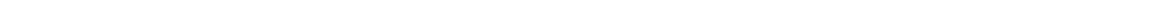
Fig. 1 Widespread intronic polyadenylation in immune cells. a Schematic representation of full-length and IpA isoform of IGHM expressed in mature B cells and plasma cells (PC). b The 3 ʹ -seq (tags per million (TPM)) and RNA-seq (read coverage) tracks showing expression of the IpA and full-length mRNA isoforms of IGHM (ENSG00000211899), encoding the immunoglobulin mu heavy chain, IgM. The full-length isoform is expressed in NB from blood and lymphoid tissue and includes two exons encoding the C-terminal transmembrane domain of membrane-bound IgM. The IpA isoform is expressed in PCs obtained from bone marrow. It lacks the transmembrane domain which leads to expression of soluble IgM. c The 3 ʹ -seq tracks showing IpA isoform expression for two genes across human tissues and immune cell types. d RNA-seq coverage of intronic regions fl anking IpA sites. A GLM-based test is used to validate the IpA isoforms. An isoform is considered validated if there is a signi fi cant difference (FDR-adjusted P < 0.1) in read counts in windows located up- and downstream of the putative IpA site. e The fraction of IpA isoforms validated by read evidence from independent data sets is shown for annotated and unannotated IpA isoforms. IpA isoforms present in RefSeq, UCSC genes, and Ensembl databases are considered to be annotated. f The fraction of expressed genes that generate IpA isoforms is shown for each cell type. g Expression levels (log 2 TPM) for full-length mRNAs and IpA isoforms are shown as boxplots for in PCs, blood NB, and T cells. IpA isoforms are robustly expressed as full-length mRNA expression is 4.53, 5.15, and 5.11, respectively, compared to 3.71, 3.83, and 3.71 for IpA isoforms. h Tissue-speci fi c expression of IpA isoforms. Each row represents a gene. Dark blue, IpA isoform is expressed ( ≥ 5 TPM); light blue, IpA isoform is not expressed, but full-length mRNA is expressed ( ≥ 5.5 TPM); and white, gene is not